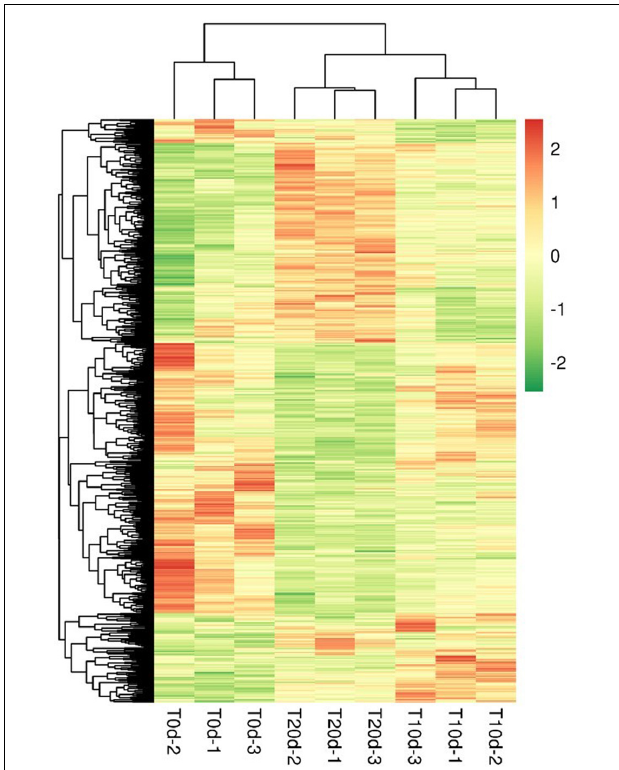
FIGURE 6 | Cluster analysis of differentially expressed proteins. Through a horizontal comparison, the samples could be classified into three categories, suggesting that the selected DEPs could effectively be distinguished among the samples. A vertical comparison indicated that proteins could be classified into two categories with opposite directional variation, demonstrating the rationality of the selected